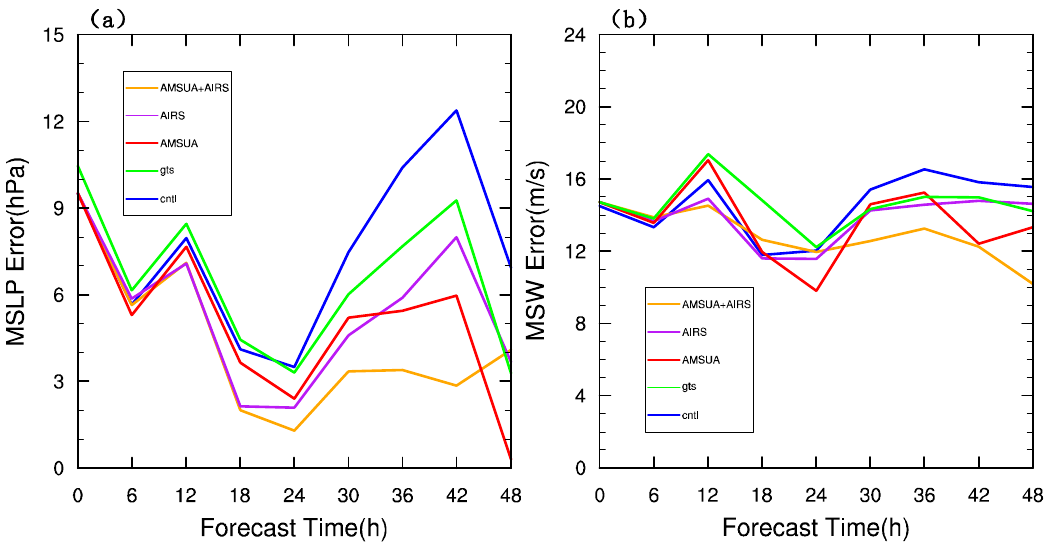
Figure 12. ( a ) Minimum sea level pressure (MSLP) error (unit: hPa) and ( b ) maximum surface wind (MSW) error (unit: m/s).